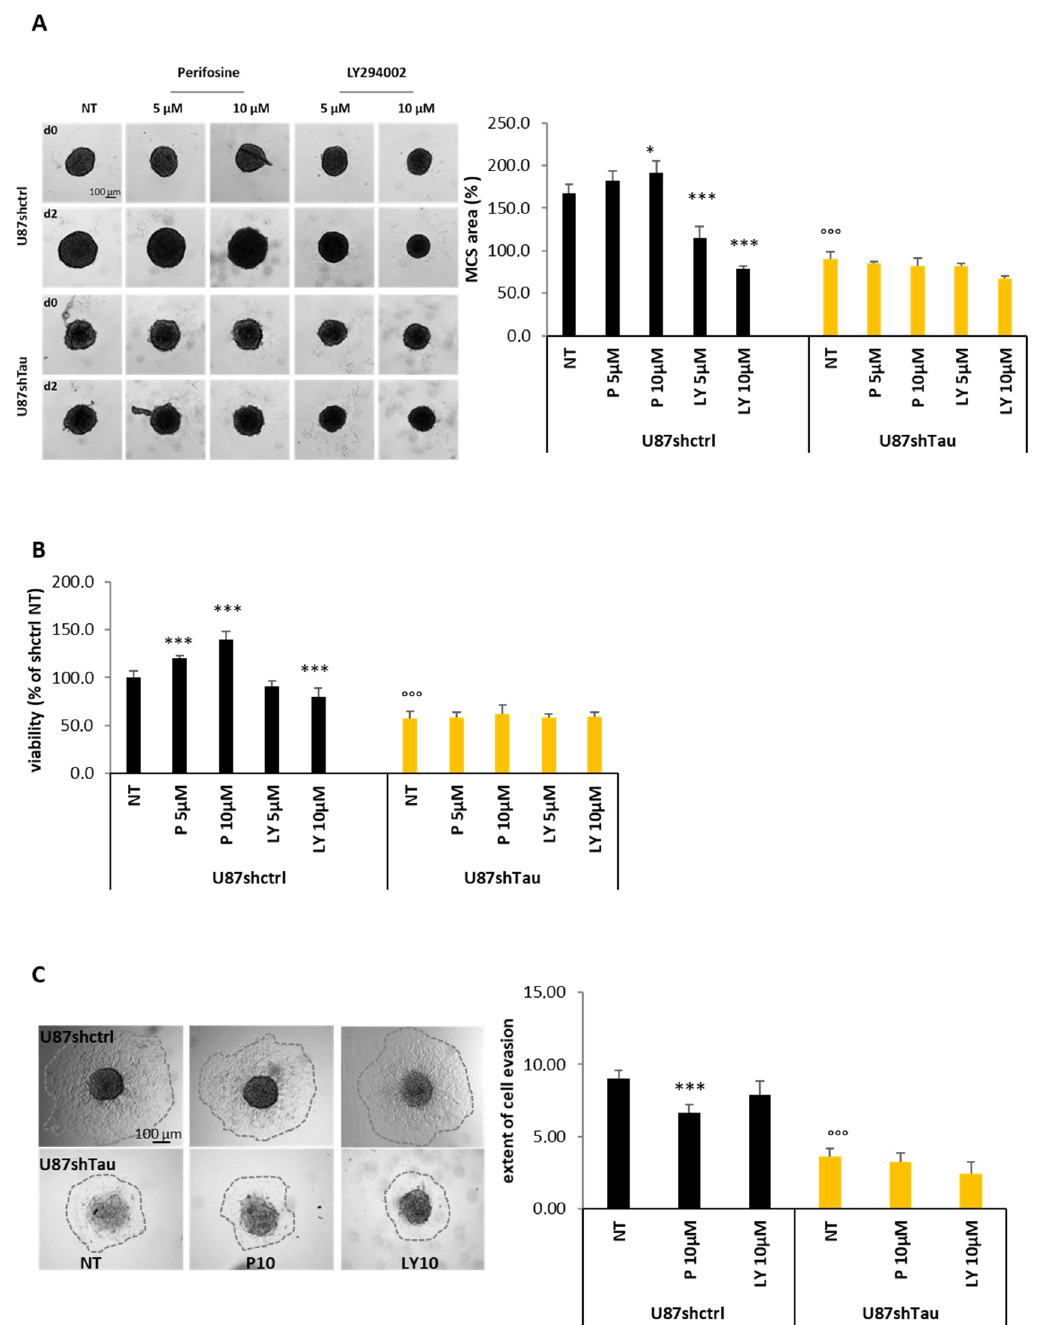
Figure 7. The PI3k-/Akt signaling pathway is differentially implicated in Tau-dependent MCS growth and evasion. ( A ) Effect of PI3-K and Akt inhibition on spheroids growth in 20% methylcellulose. On day 1 of spheroid formation (d0) spheroids were treated or not (NT) with Perifosine (P 5-10 µM) or LY294002 (LY 5–10 µM) for 2 days. Left: representative images are shown. Lower part: quantification of the apparent area occupied by MCS. Values are expressed as % of area occupied by MCS before treatment (D0; * p < 0.05, *** p < 0.001 U87shctrl NT vs. U87shctrl P10 µM, LY 5 µM and LY 10 µM, respectively; °°° p < 0.001 U87shctrl NT vs. U87shTau NT; N = 8). ( B ) Effect of Akt inhibition on spheroid cell viability (MTT assay). Values were expressed as % of NT U87shctrl condition (*** p < 0.001 U87shctrl NT vs. U87shctrl P5 P10 and LY 10 µM, respectively; °°° p < 0.001 U87shctrl NT vs. U87shTau NT, N = 8). ( C ) Effect of PI3K -Akt inhibition on cell evasion from spheroids. Left: representative images of evasion at time 9 h. Right: quantification of evasion. Results are expressed as the ratio of the area occupied by the migrating cells from the spheroid on the area of the spheroid at time 0 h ( N = 12; *** p < 0.001 U87shctrl vs. U87shctrl P10 µM; °°° p < 0.001 U87shctrl NT vs. U87shTau NT).